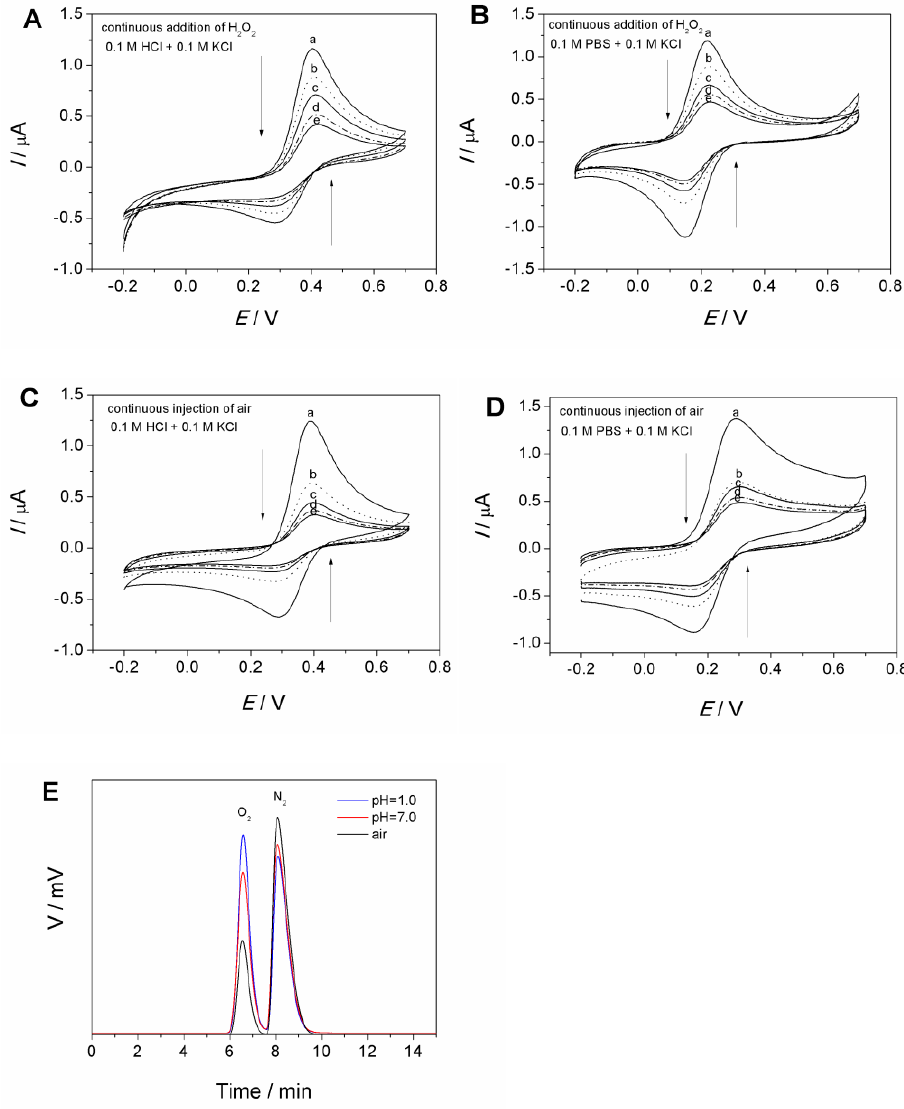
Figure 4. ( A ) CVs of MCF-IL-Fe(CN) 63 − /PVA electrode in 0.1 M HCl + 0.1 M KCl solution and ( B ) that in 0.1 M PBS + 0.1 M KCl solution upon the continuous addition of H 2 O 2 (a–e); ( C ) CVs of MCF-IL-Fe(CN) 63 − /PVA electrode in 0.1 M HCl + 0.1 M KCl solution and ( D ) that in 0.1 M PBS + 0.1 M KCl solution upon the continuous injection of 10 mL air (a–e). Potential range: − 0.2 V~0.7 V; scan rate: 100 mV s − 1 ; ( E ) gas chromatogram of air (black line) and gas collected after Fe(CN) 63 − reaction with H 2 O 2 in 0.1 M HCl + 0.1 M KCl solution (blue line) and 0.1 M PBS + 0.1 M KCl solution (red